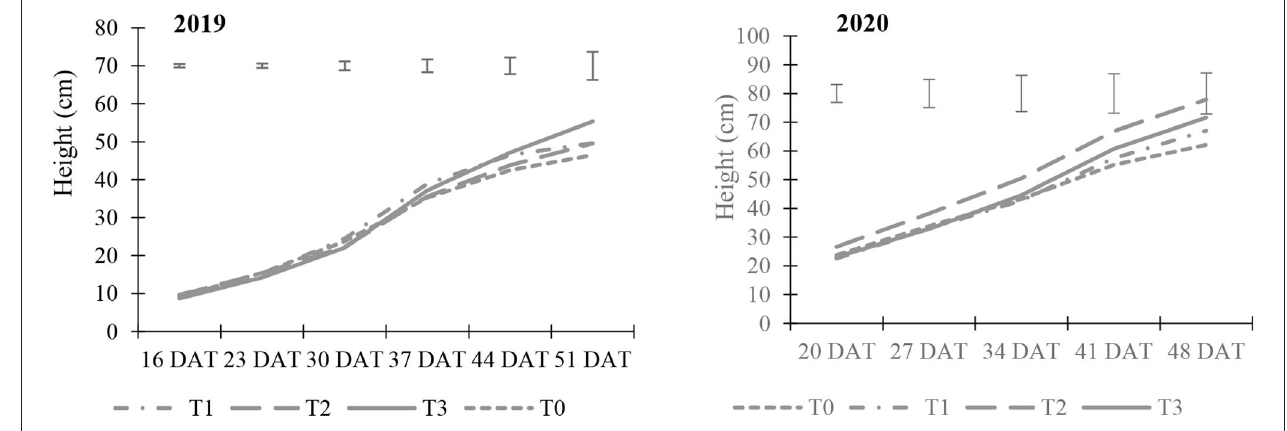
FIGURE 2 | Weekly tomato plant height days after transplanting (DAT).